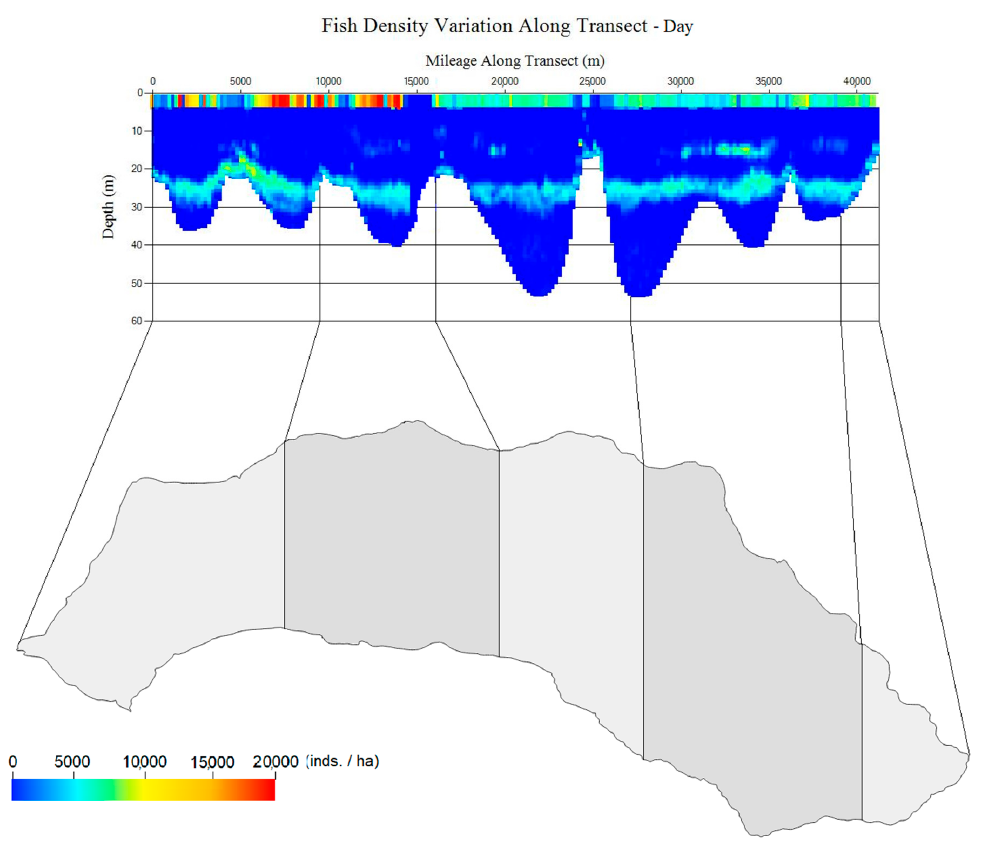
Figure 7. Color map of daytime fish density depth-wise and along transect variations. Figure is 7 spatially referenced with respect to the